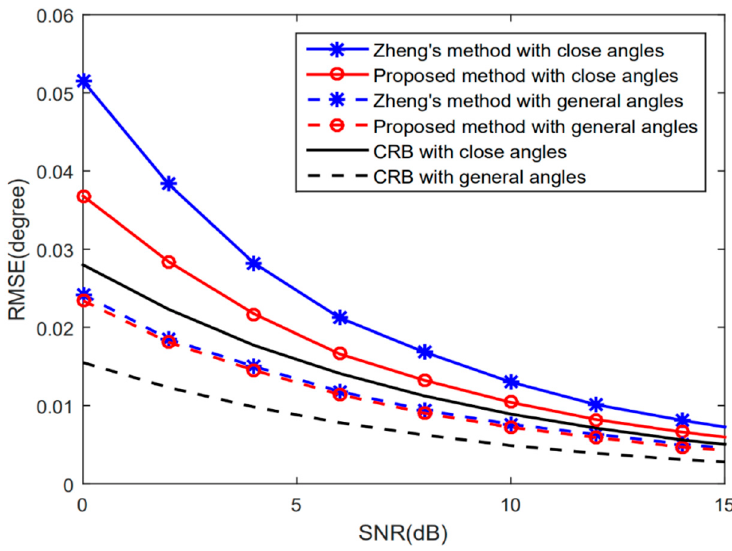
Figure 2. Root mean square error ( RMSE ) performance versus signal-to-noise ratio ( SNR ) .